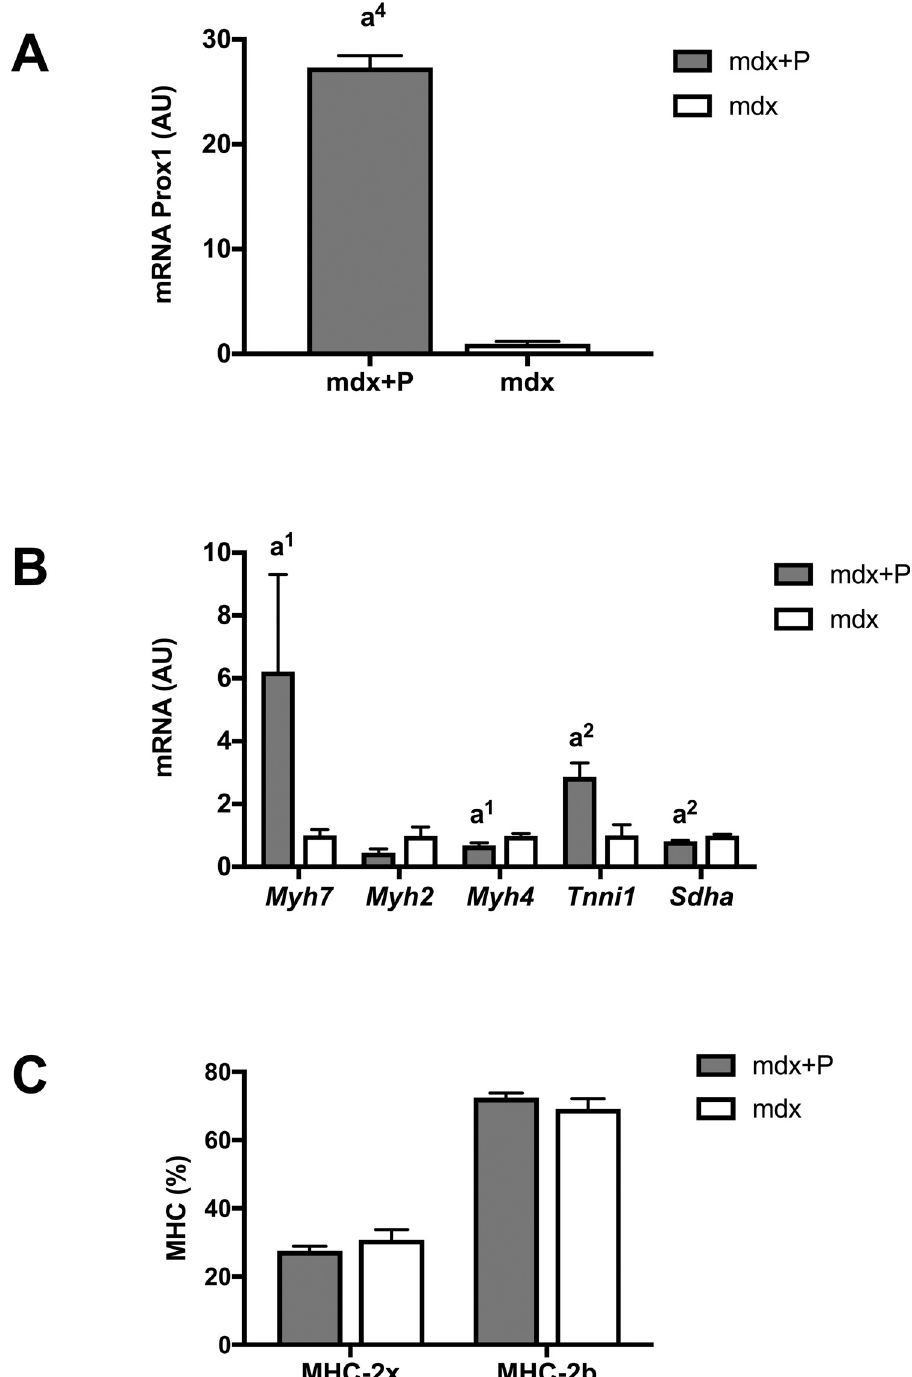
Fig 5. Effect of Prox1 transfer on the expression of Prox1 and markers of fibre type specification in sedentary mdx mice (second set of experiment). (A) Prox1 expression in Mdx+P and Mdx muscle. N = 6–11 per group. (B) Expression of genes encoding fibre type specific contractile proteins in Mdx+P and mdx muscles. N = 6–11 per group. (C) Relative amounts of MHC-2x and MHC-2b proteins in Mdx+P and Mdx muscle. N = 3 per group. Mdx+P: Mdx muscle that received Prox1 transfer into the muscle. Mdx: Mdx muscle. a1, a2, a4: significant different from Mdx, p < 0.05, p < 0.01, p < 0.0001, respectively.